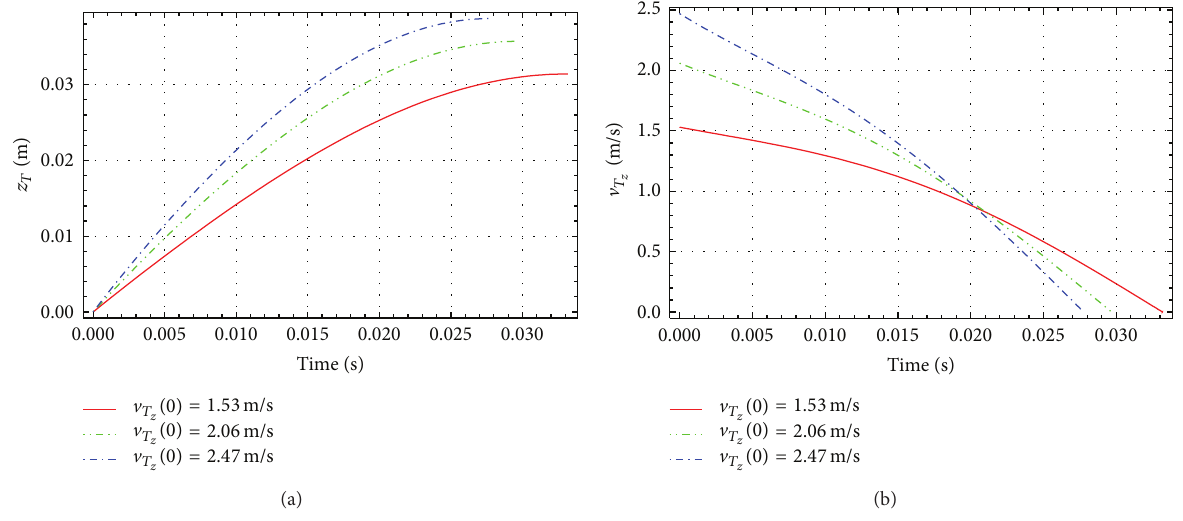
Figure 4: Vertical impact: penetrating depth 𝑧 𝑇 and vertical velocity V 𝑇